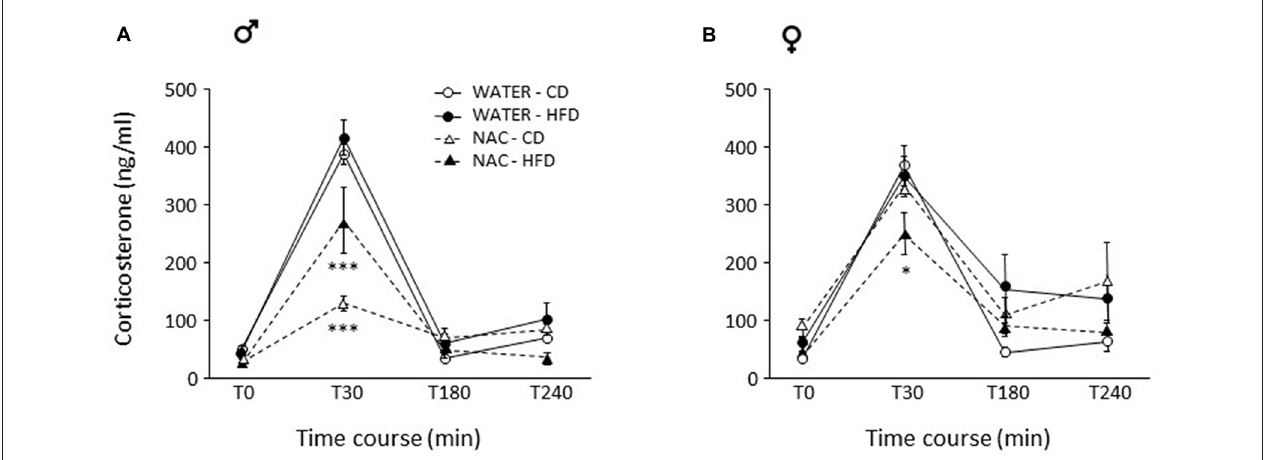
FIGURE 5 | Activation of the hypothalamus-pituitary-adrenal (HPA) axis after restraint stress. (A) In males, NAC led to overall decreased corticosterone (CORT) levels. This decrease was stronger in NAC-CD subjects, maternal HFD reducing this effect. (B) In females, the combination of prenatal NAC and HFD led to a reduction in CORT levels comparable to that observed in NAC-HFD males while NAC alone did not affect this parameter. Data are mean ± SEM. ∗∗∗ p < 0.001 (A) NAC-CD vs. all other groups and NAC-HFD vs. all other groups; ∗ p < 0.05 (B) 30 min, NAC-HFD vs. all other groups.